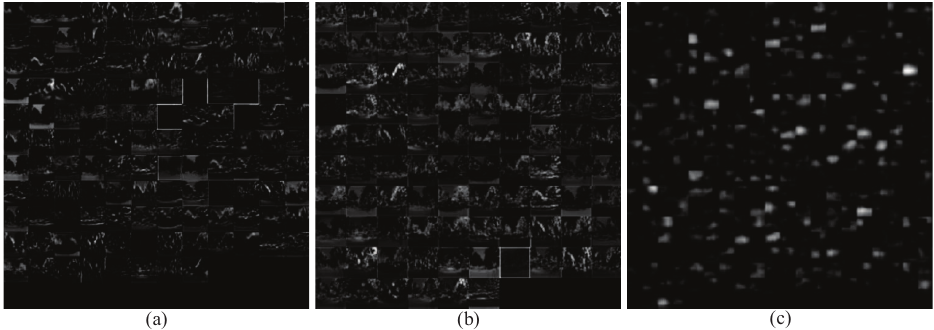
Figure 15. The feature maps extracted from different layers of GoogLeNet: ( a ) Inception3a/3 × 3 is comprised of 28 × 28 × 128 feature maps; ( b ) Inception3a/3 × 3_reduce is comprised of 28 × 28 × 96 feature maps; and ( c ) Inception5b/1 × 1 is comprised of 7 × 7 × 384 feature maps.